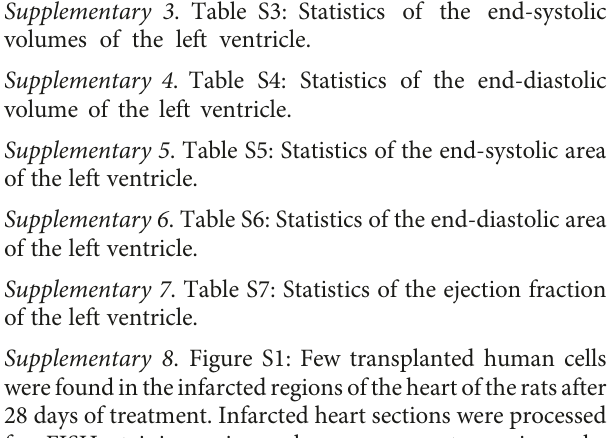
Supplementary 2 . Table S2: Heart rate statistics. Supplementary 3 . Table S3: Statistics of the end-systolic volumes of the left ventricle. Supplementary 4 . Table S4: Statistics of the end-diastolic volume of the left ventricle. Supplementary 5 . Table S5: Statistics of the end-systolic area of the left ventricle. Supplementary 6 . Table S6: Statistics of the end-diastolic area of the left ventricle. Supplementary 7 . Table S7: Statistics of the ejection fraction of the left ventricle. Supplementary 8 . Figure S1: Few transplanted human cells were found in the infarcted regions of the heart of the rats after 28 days of treatment. Infarcted heart sections were processed for FISH staining using a human pancentromeric probe (red). Nuclei were stained with DAPI (blue). Representative photomicrograph of the three groups: control/vehicle (A), transplanted with puri fi ed CD133 + cells (B), and expanded CD133 + cells (C). Scale bars: 7.5 μ